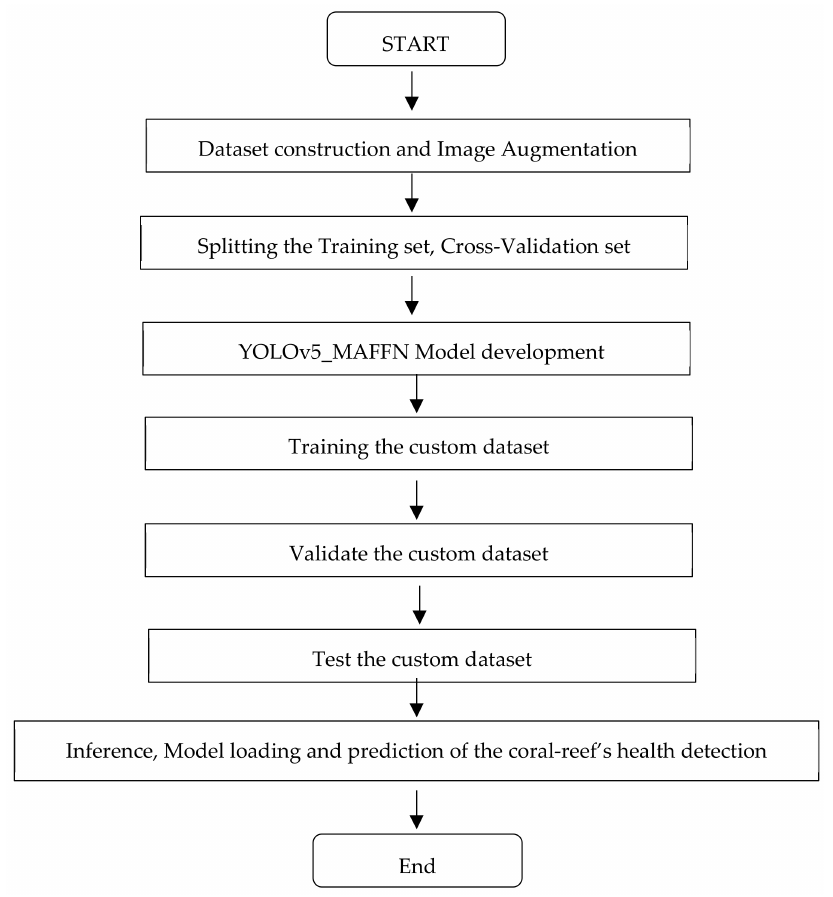
Figure 18. Flow chart of the YOLOv5-MAFFN model-based health detection